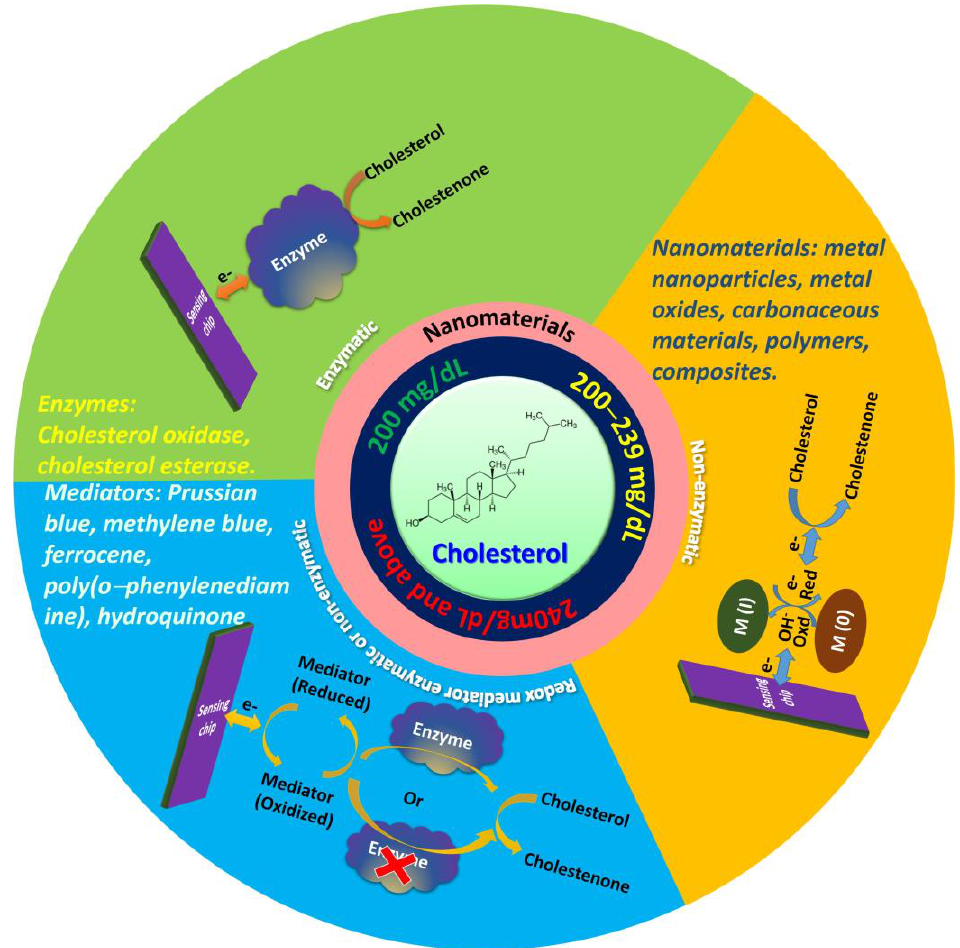
Figure 1. Schematic of electrochemical cholesterol sensors.